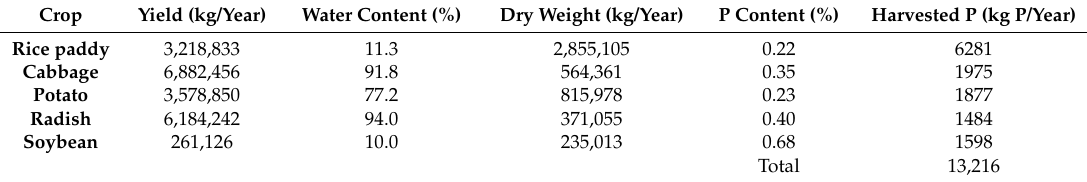
Table 6. Phosphorus outputs from the watershed through crop harvesting.